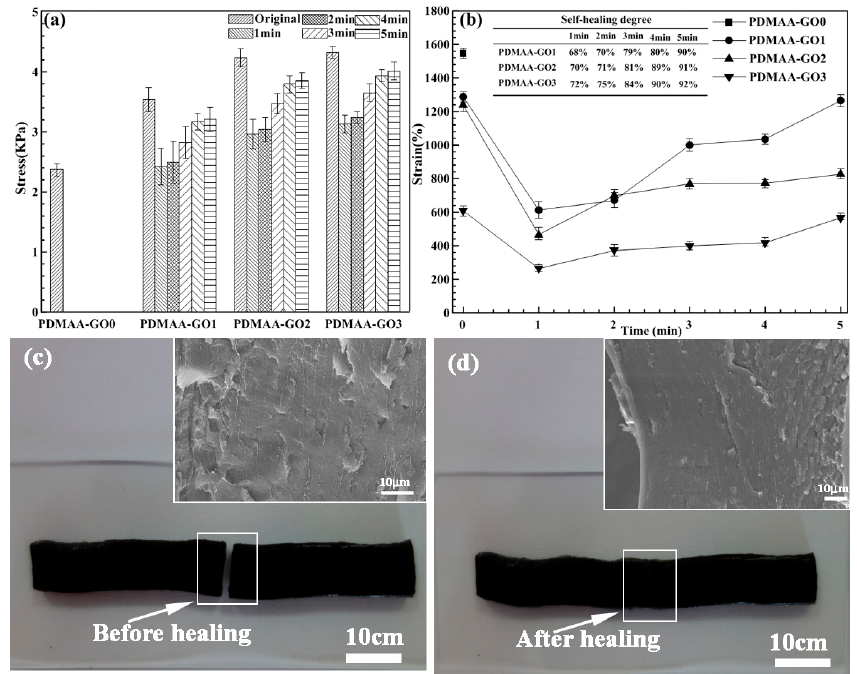
Figure 6. ( a ) Stress values, ( b ) strain values, and the corresponding self-healing degree of PDMAA hydrogels with different GO contents and self-healing time, morphology, and microstructure of PDMAA-GO3 hydrogel ( c ) before and ( d ) after 5 min of self-healing.